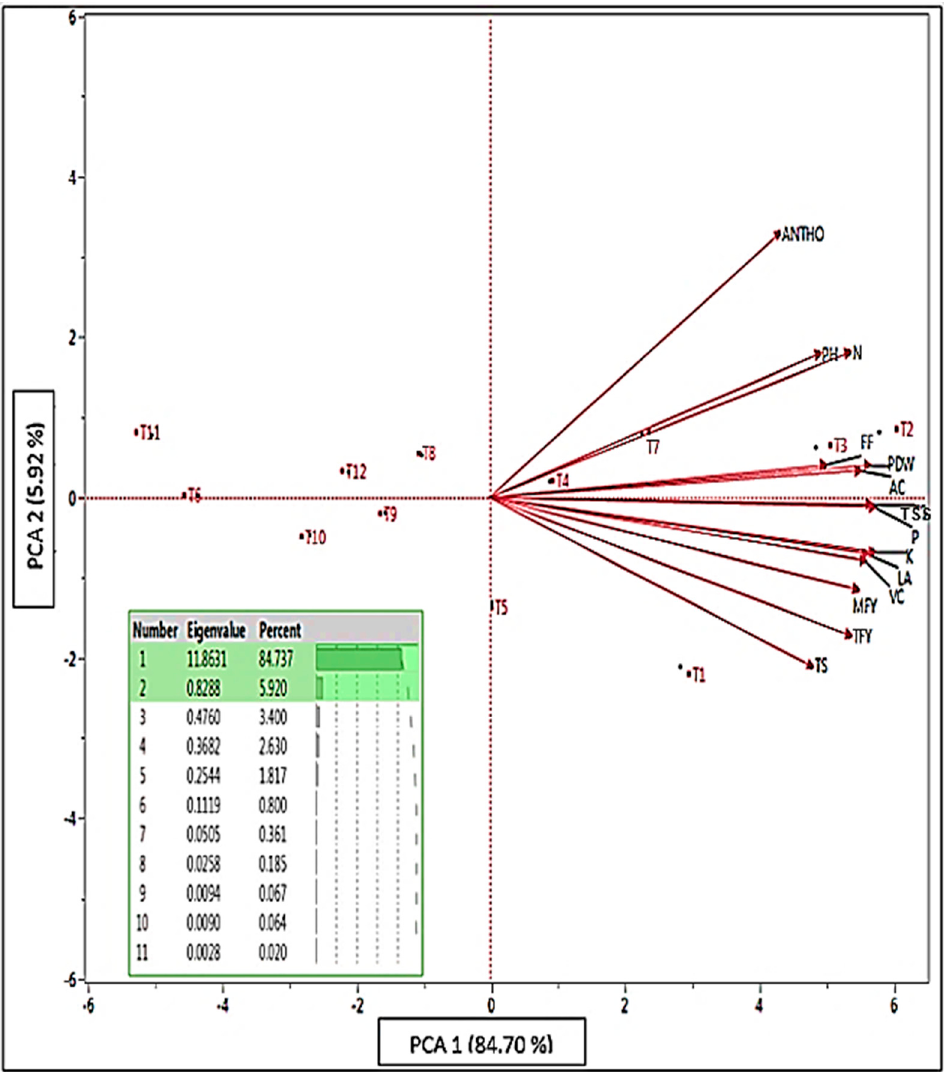
Figure 3. Vector view of the biplot depicting the interrelationship among studied treatments and traits of strawberry plants. ANTHO, anthocyanin; PH, plant height; N, nitrogen; FF, fruit firmness; PDW, plant dry weight; AC, acidity; TSS, total soluble solids; P, phosphorus; K, potassium; LA, leaf area; VC, vitamin C; MFY, marketable fruit yield; TFY, total fruit yield; TS, total sugar. The lines emanating from the central point of each biplot indicate positive or negative correlations of different variables, whereas their proximity indicates the strength of the correlation with specific treatments. Strawberry marketable fruit yield (MFY) was strongly positively associated with all studied traits because the vector trait of MFY formed an acute angle of less than 90 degrees (<90 ◦ ) with the vectors of these traits. The small acute angles between the vectors of PH, N, FF, PDW, AC, TSS, P, K, LA, VC, MFY, TFY, and TS were highly positively correlated. There was a near-zero correlation between ANTHO and TS due to the nearly perpendicular vectors (r = cos 90 = 0). The biplot model also explained 90.62% of the total variation in the standardized data. The first two principal components (PCA 1 and PCA 2) explained 84.70% and 5.92% of the variance, respectively. The